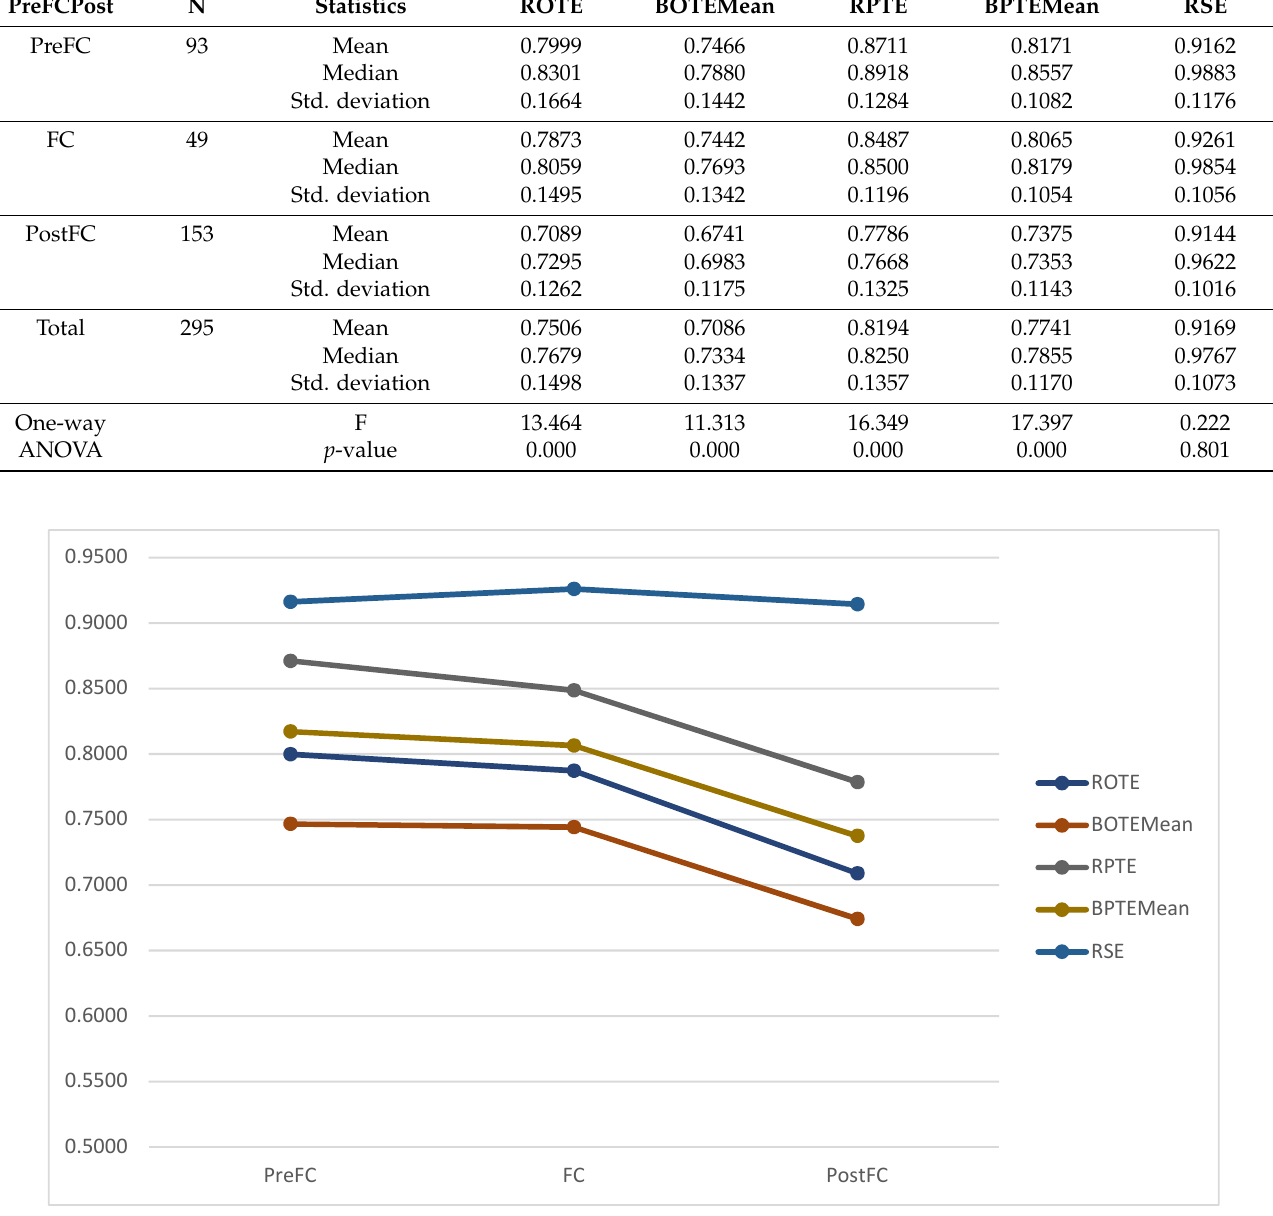
Figure 9. Efficiency scores of power-generating companies per subperiod (PreFC, FC, PostFC).